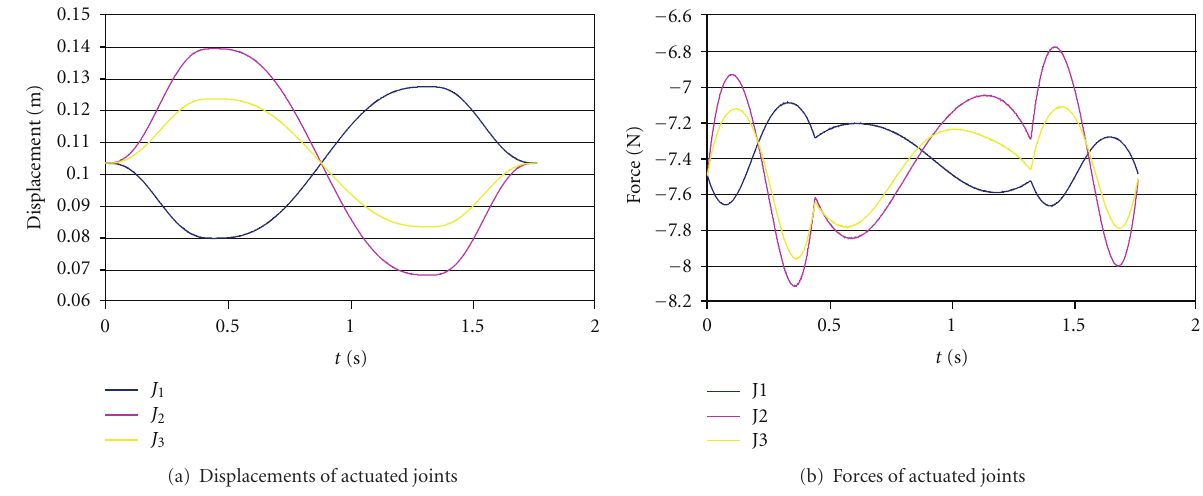
Figure 5: Estimation of driving forces based on a dynamic